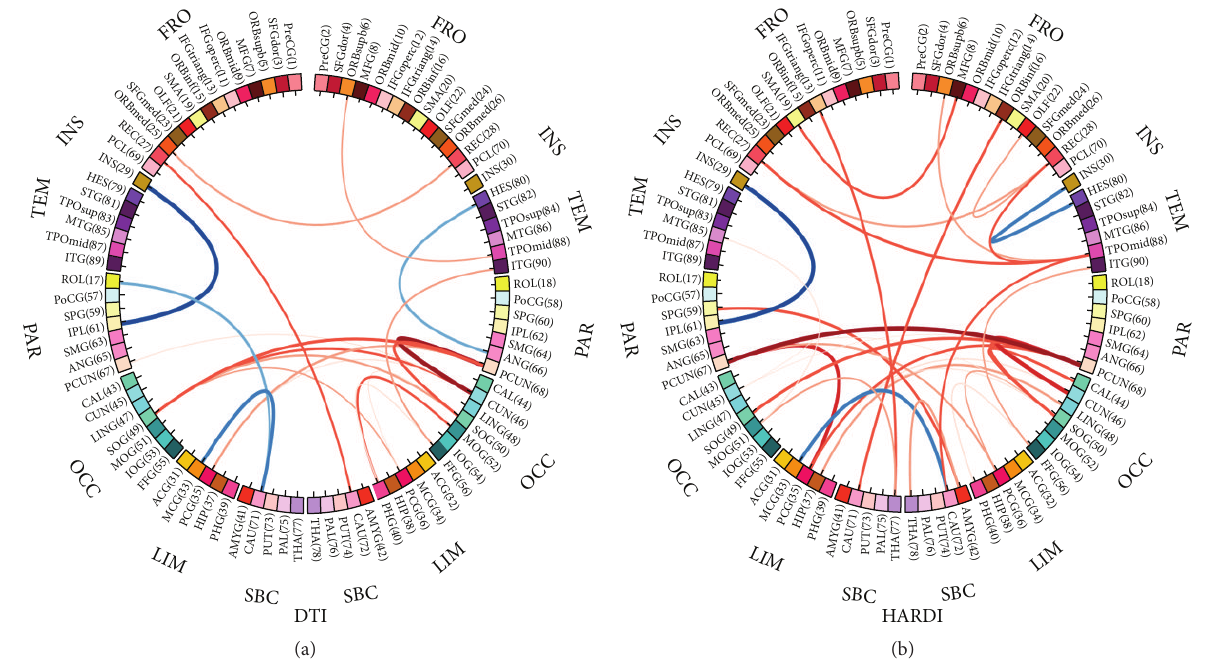
Figure 7: Connectograms showing significantly different connections ( 𝑝 < 0.05 ) based on the fiber counts between the AD group and the NC group, given (a) the DTI method and (b) the HARDI method. The thickness of each line indicates the extent of the difference between the corresponding connections in the two groups. The stronger connections (higher fiber counts between a pair of ROIs) in the AD group are shown in blue , while the weaker connections (lower fiber counts between a pair of ROIs) are in red . Refer to Table 2 for the label of each